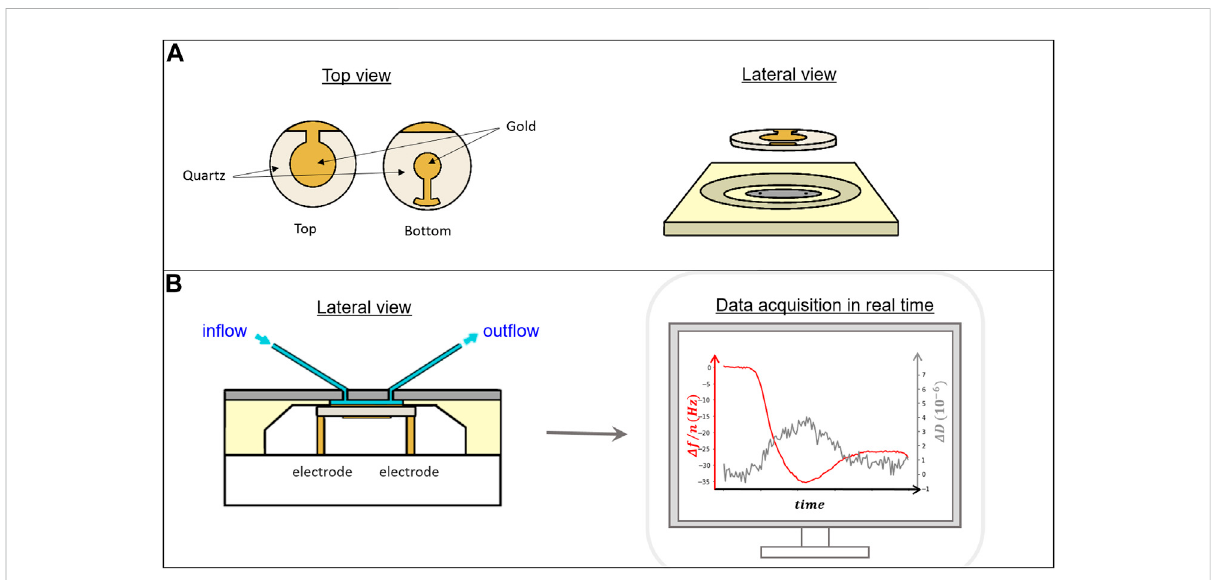
FIGURE 4 (A) Top and side view of a quartz crystal showing the gold electrodes on top and bottom that allow the connection to electrically drive the crystaloscillation. (B) LateralviewofadiagramoftheQCMmeasuringchamber(left).Thecrystalisinsertedintoasealedchamberthatallowscontact with the electrodes from the bottom and exposure of the active upper region to liquid that can be exchanged through a pumping system. Right, example of a typical data acquisition set where the frequency drop (red line) registered follows the adsorption of material to the crystal surface and the dissipation in real time (gray line) (Figure 5 for further